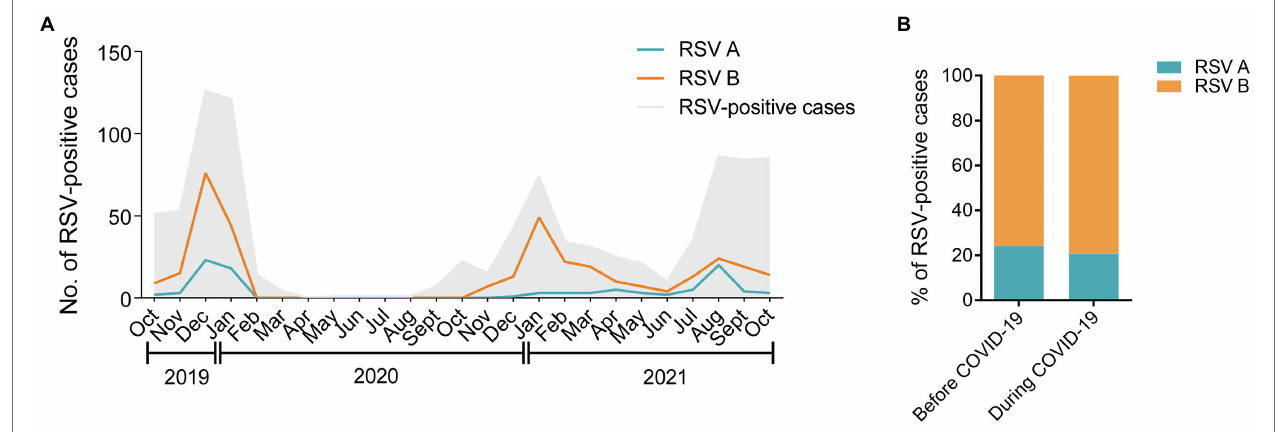
FIGURE 2 | Distribution of RSV A and B subgroups among children before and during COVID-19. (A) The monthly distribution of RSV A and B from October 2019 to October 2021. The gray shadow represents the total number of all the RSV-positive inpatients admitted to the hospital. The blue and orange lines represent the numbers of RSV A- or B-positive inpatients enrolled in the study, respectively. (B) The proportions of RSV A- or B-positive inpatients enrolled in the study before and during COVID-19.